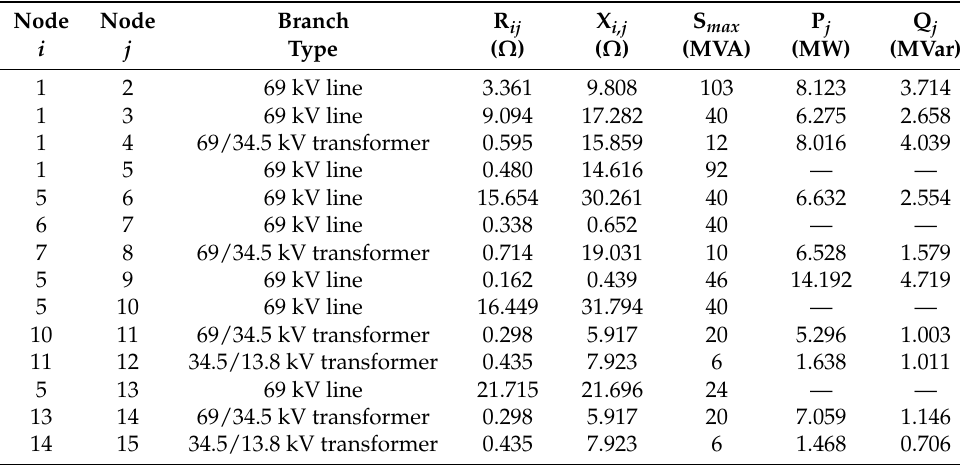
Table 1. Case study: electrical branch parameters (lines and transformers) and data nodes.